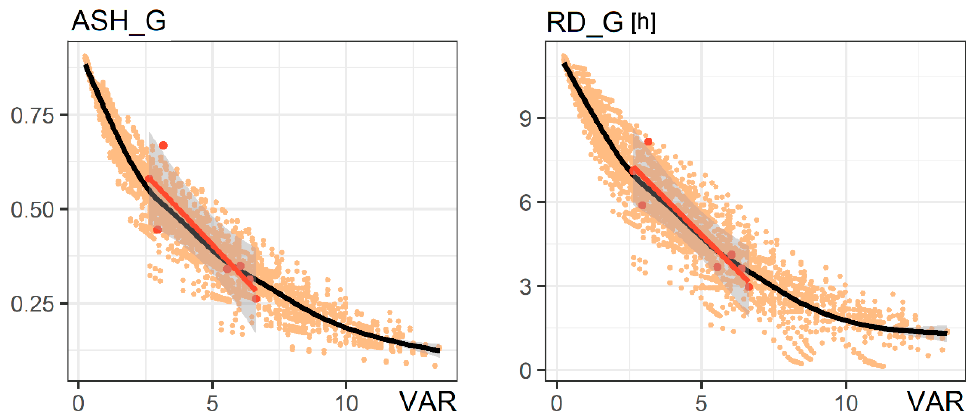
Figure 17. Non-linear regression functions of density metric VAR with L-metrics ASH_G ( left ) and RD_G ( right ) based on neighbourhood iterations (black line) and case-study-fitted linear regression line (red) with 95% CI in grey. The case study linear regression approximates the respective section of the non-linear regression from iterations.